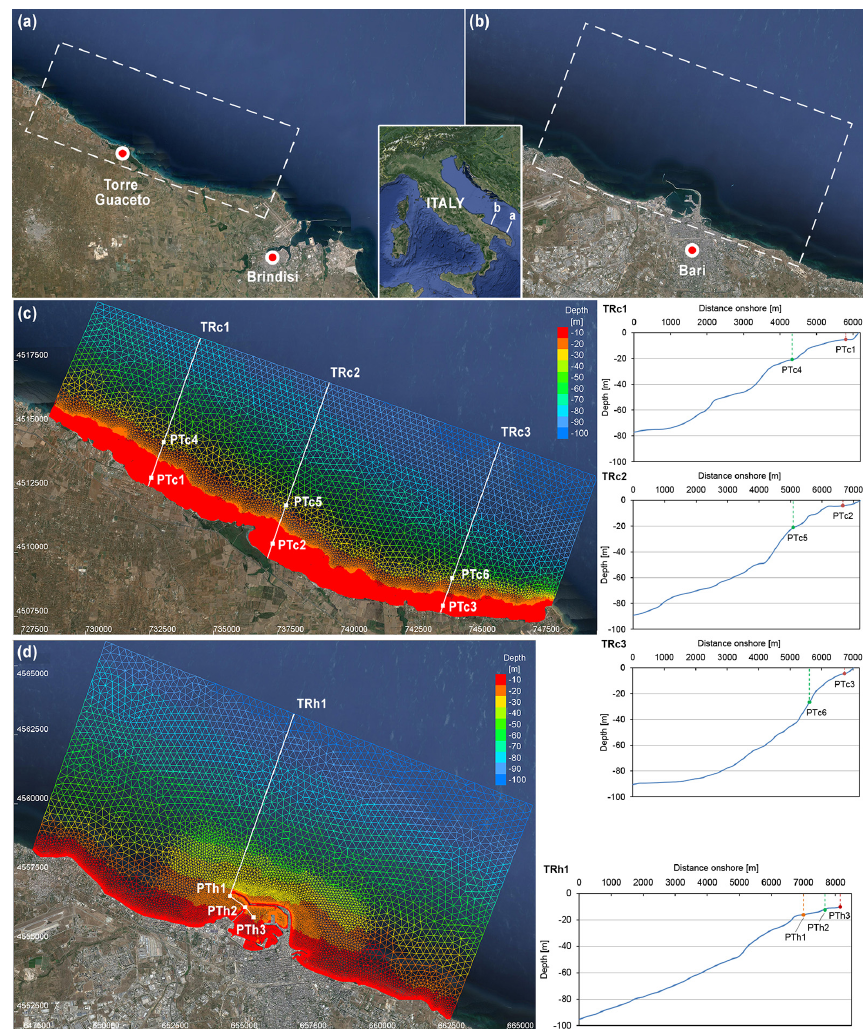
Figure 1. Satellite images of the wider areas, outlines of the computational domains, meshes, bathymetries, linear transects and points for results’ analysis for the Brindisi–Torre Guaceto (a, c) and Bari (b, d) case studies (background images from Google Earth, 2016; privately